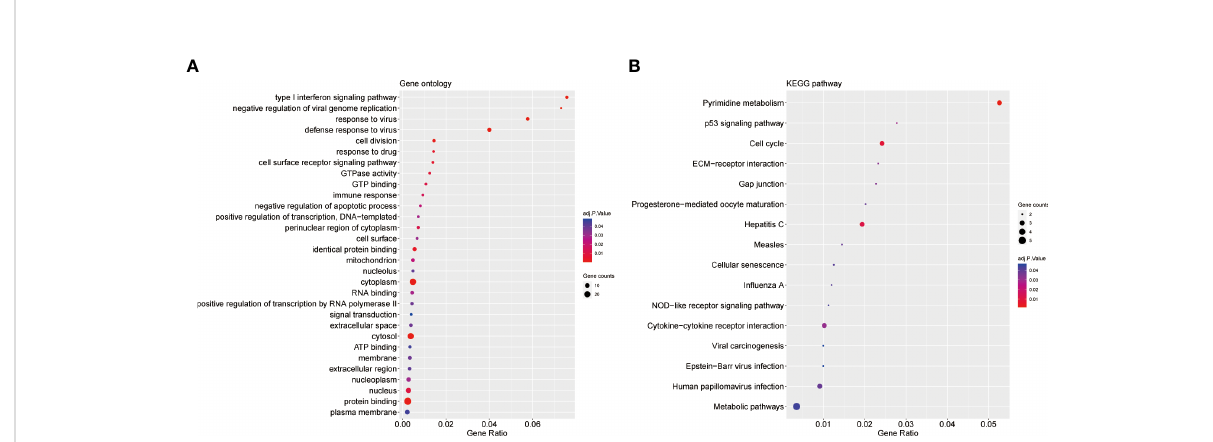
FIGURE 3 GO and KEGG enrichment analysis of common DEGs. (A) The enrichment analysis results of GO. (B) The enrichment analysis results of KEGG Pathway. Adjusted P-value < 0.05 was considered signi fi